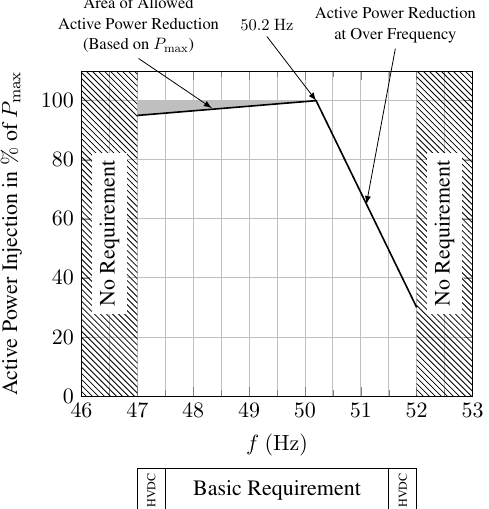
Figure 2. Requirements for the frequency-dependent power supply of generators connected via HVDC systems (based on